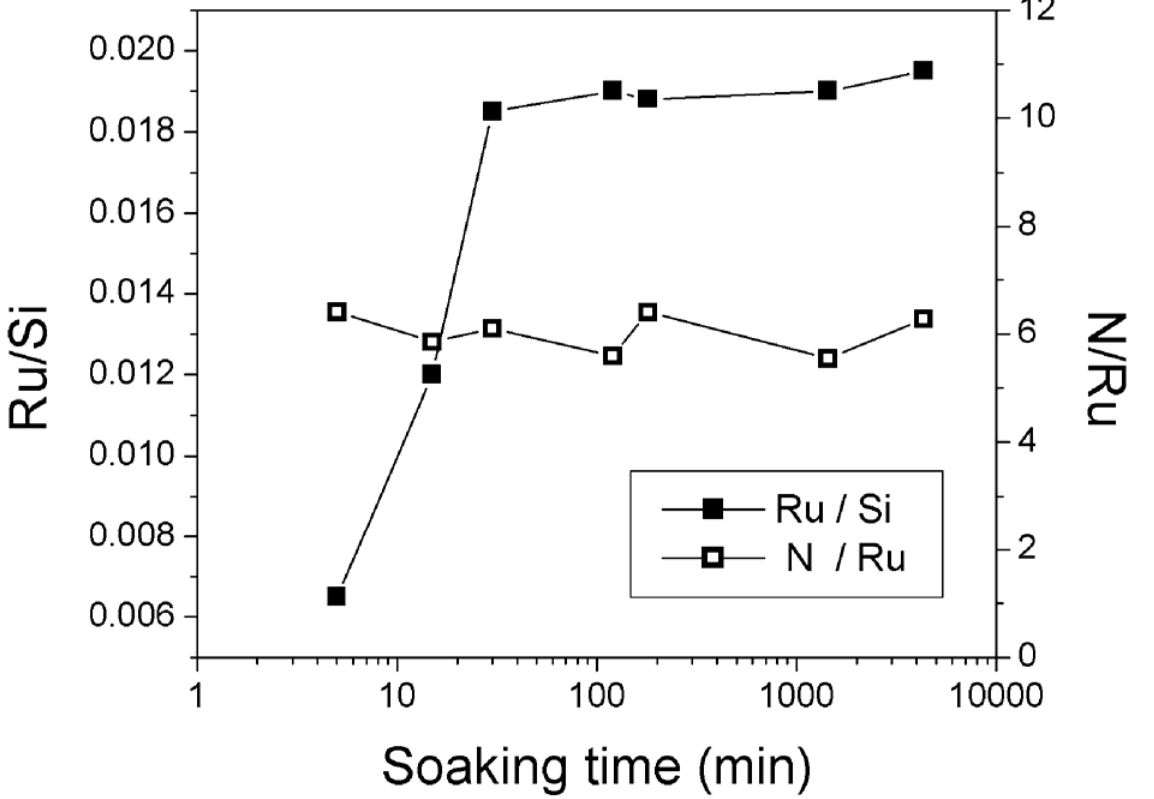
Figure 8. Time-dependent XPS results of the attachment of the Creutz-Taube ions on SiO substrate. The N/Ru and Ru/Si ratios were plotted against the soaking time of the sample